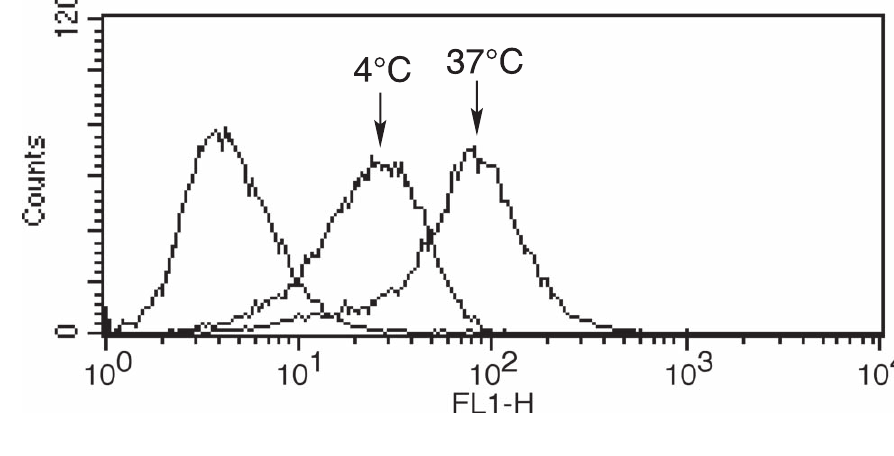
Figure 1. Confocal laser scanning microscopic analysis of macrophages co-cultured with DQ-OVA-liposome conjugates. A, DQ-OVA was coupled to either stearoyl or oleoyl liposomes and added to the culture of cloned macrophages expressing DM-DsRed (class II) or labeled with red fluorescein (class I), as described in Materials and Methods. Two hours after the onset of the culture, macrophages were recovered and analyzed using confocal laser scanning microscopy. These optically merged images are representative of most cells examined by confocal microscopy. Yellow, co-localization of green (DQ-OVA after proteolytic degradation) and red (macrophage DM or class I); cell only, macrophages without co-culture with DQ-OVA-coupled liposomes. B, the green- and yellow-color compartments in the immunofluorescent pictures were quantified by the image analysis software MetaMorph, as described in Materials and Methods. Ratios of the yellow to green compartments are shown. Data represent the mean values 6 SD of the images shown in Fig. 1A. Asterisk, significant ( p , 0.01) difference of